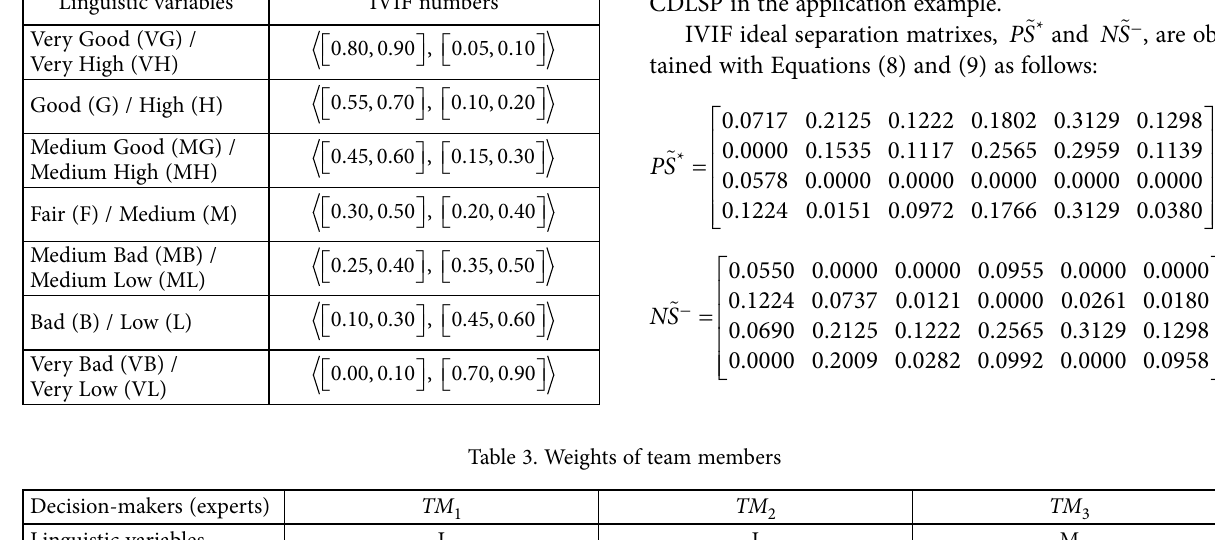
Table 6. Aggregated IVIF matrix and weights of six evaluation factors are first computed. Then, the weighted IVIF matrix is established and given in Table 7. IVIF ideal solutions are determined according to the benefit criteria for the CDLSP in the application example.